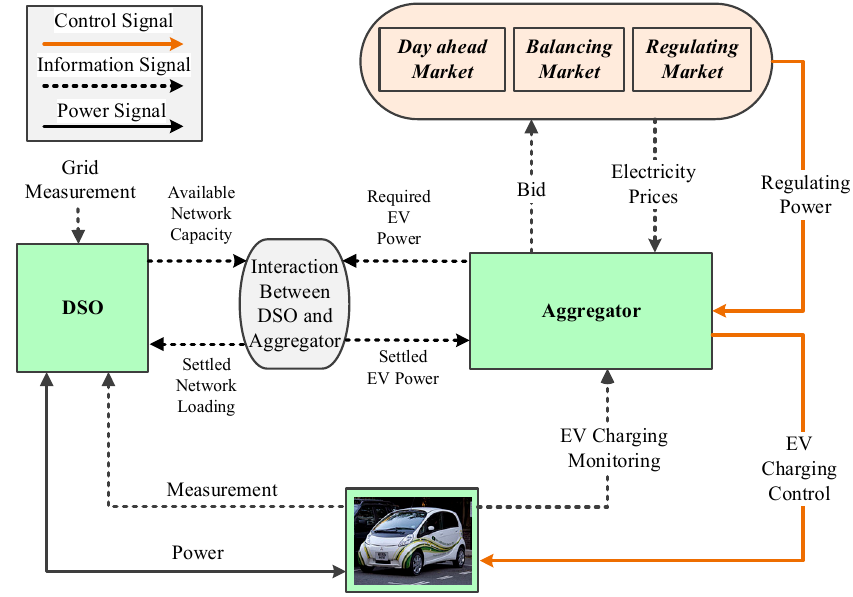
Figure 4. Schematic of EV charging coordination framework. DSO: distribution system operator.